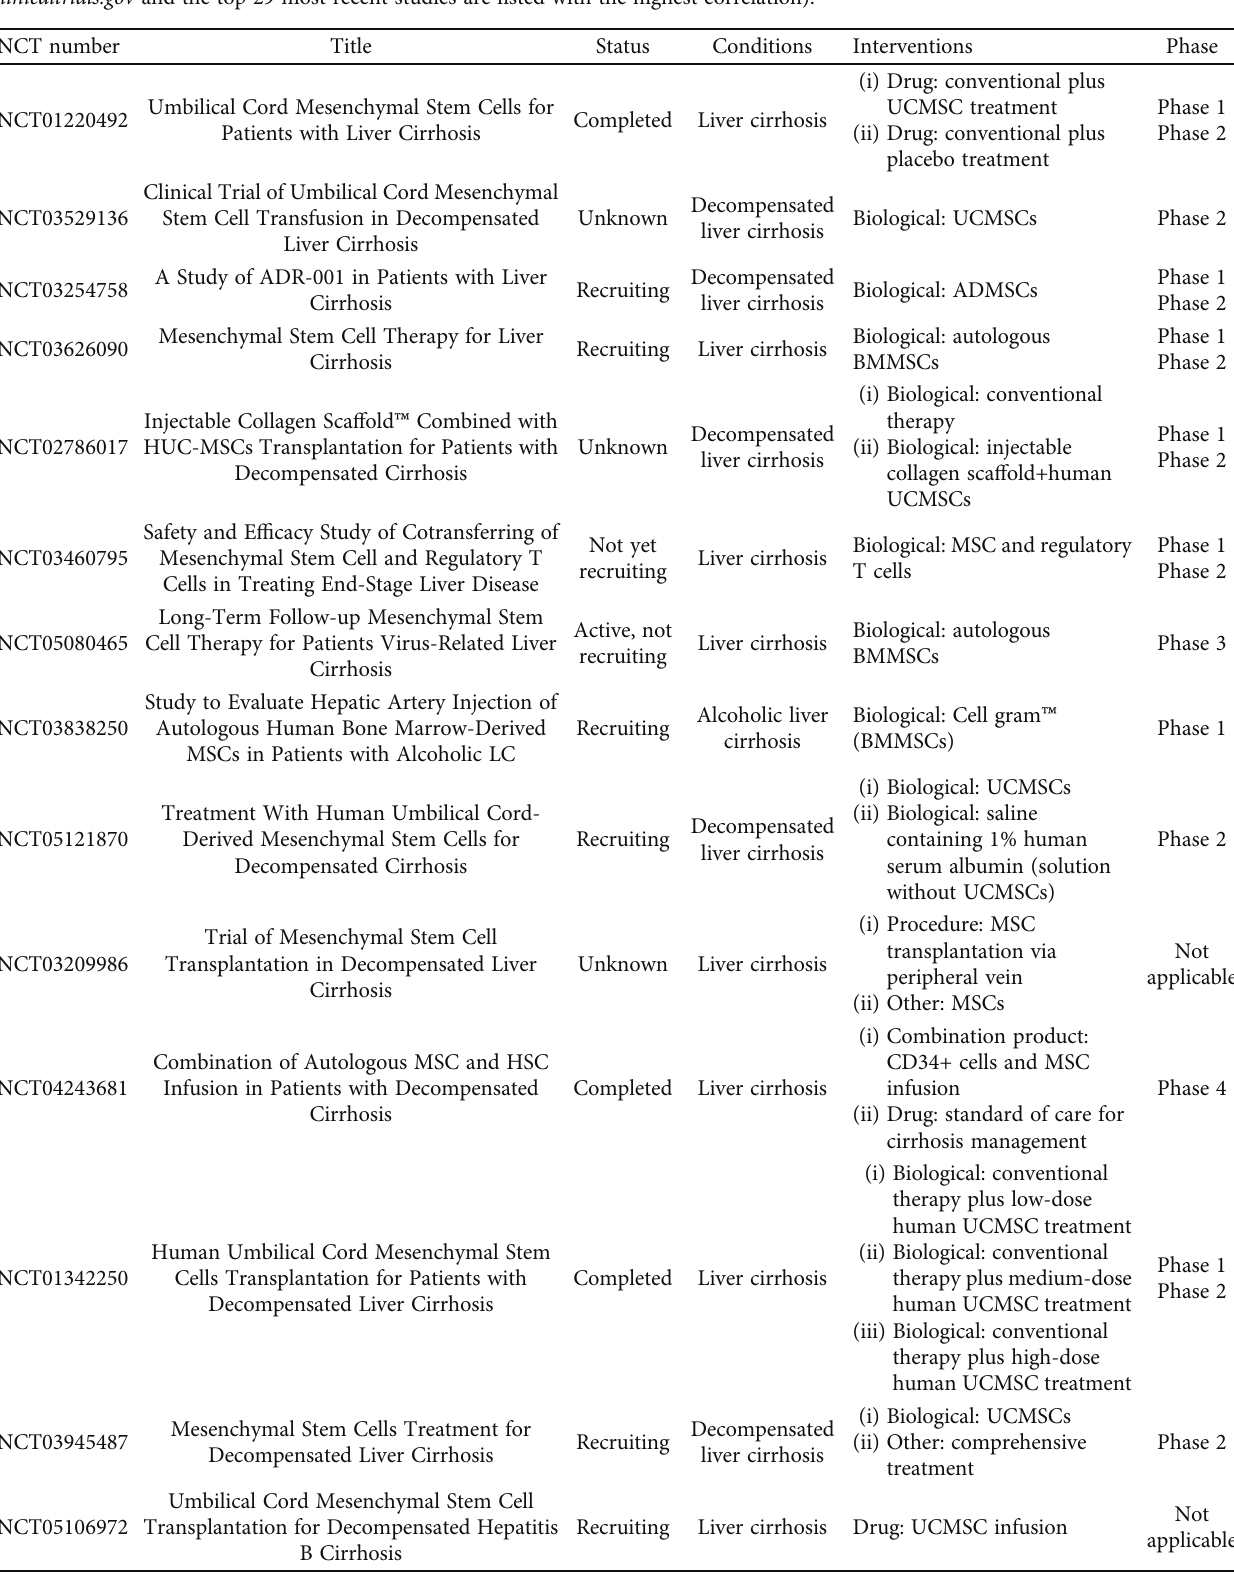
Table 2: Clinical trials registered at https://clinicaltrials.gov of MSCs in the treatment of the chronic end-stage liver diseases (of the approximately 1,348 clinical trials for liver fi brosis/cirrhosis, 68 were MSC-based cell therapy clinical trials; the data comes from https:// clinicaltrials.gov and the top 29 most recent studies are listed with the highest